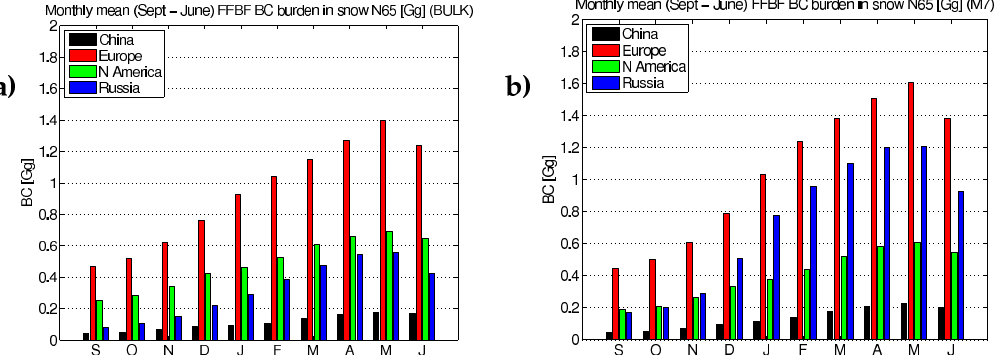
Fig. 7. Regional contribution from Europe, Russia, China and North America to monthly mean (September to June) fossil and biofuel (FFBF) BC burden [Gg] in snow and ice north of 65 ◦ N using (a) BULK and (b)